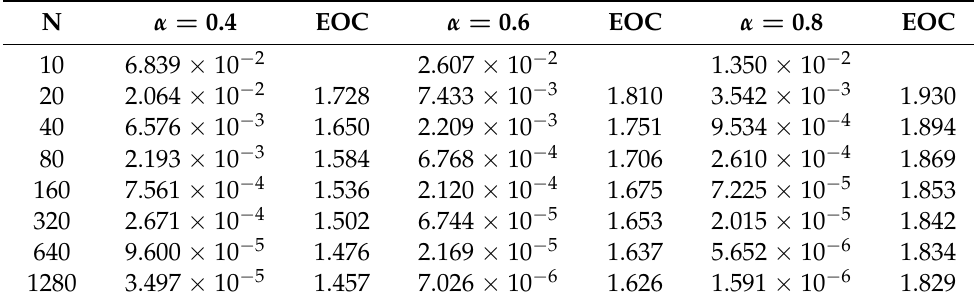
Table 1. Table showing the maximum absolute error and EOC for solving (47) using the predictor– corrector method for 0 < α < 1.